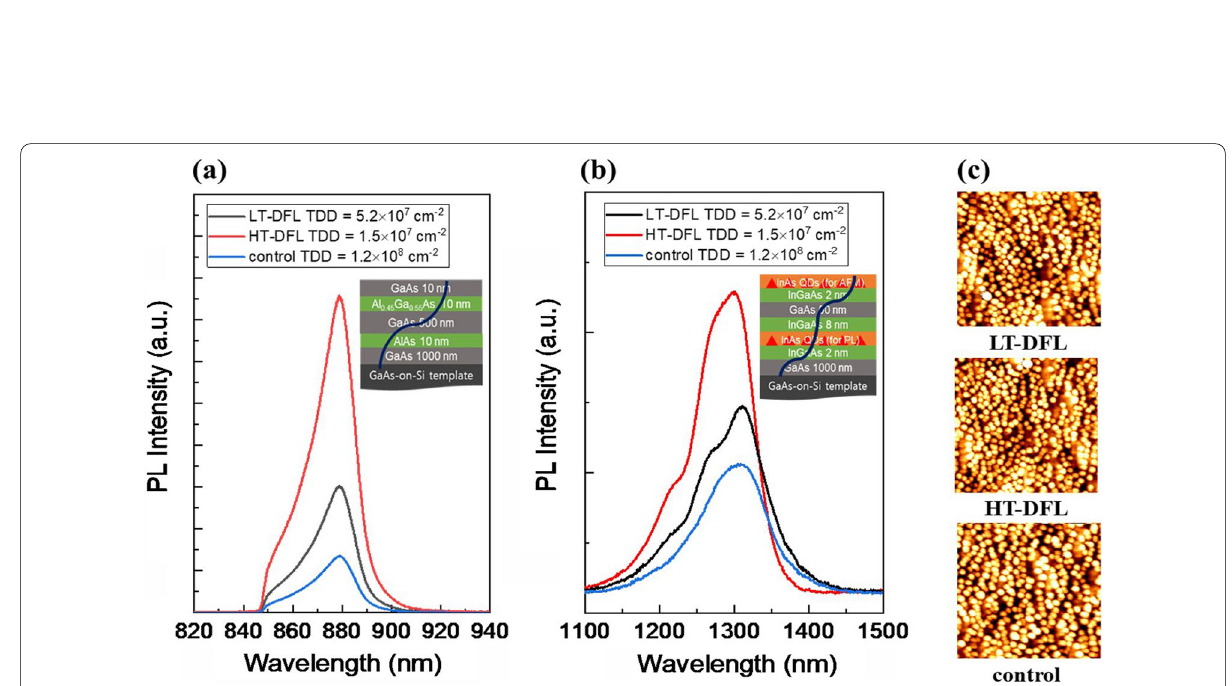
Fig. 4 a , b PL results of a regrown 500 nm GaAs bulk layer and InAs QDs, respectively. The insets are illustrations of how TD affects the GaAs buffer and InAs QDs. c AFM images of regrown QDs on GaAs‑on‑Si